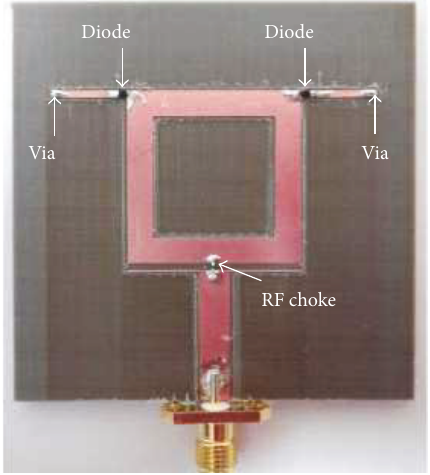
Figure 3: Picture of the fabricated